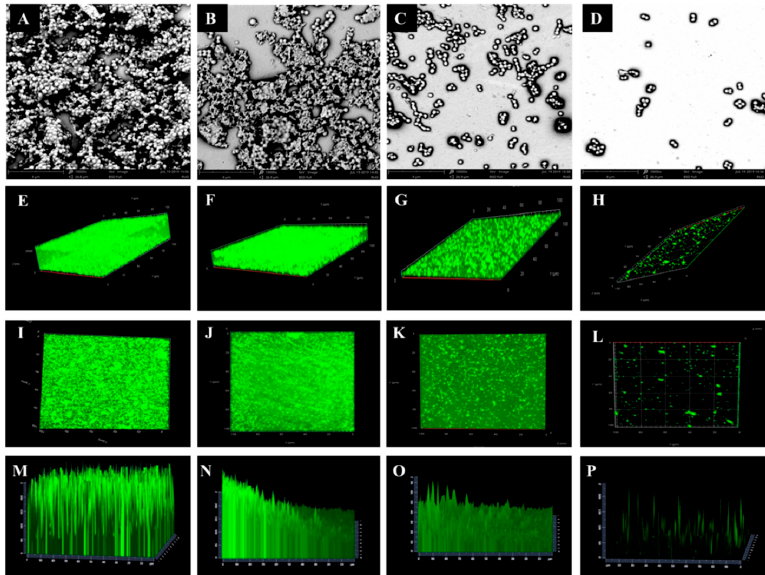
Figure 1. Scanning electron microscope (SEM) ( A – D ) and confocal laser scanning microscopy